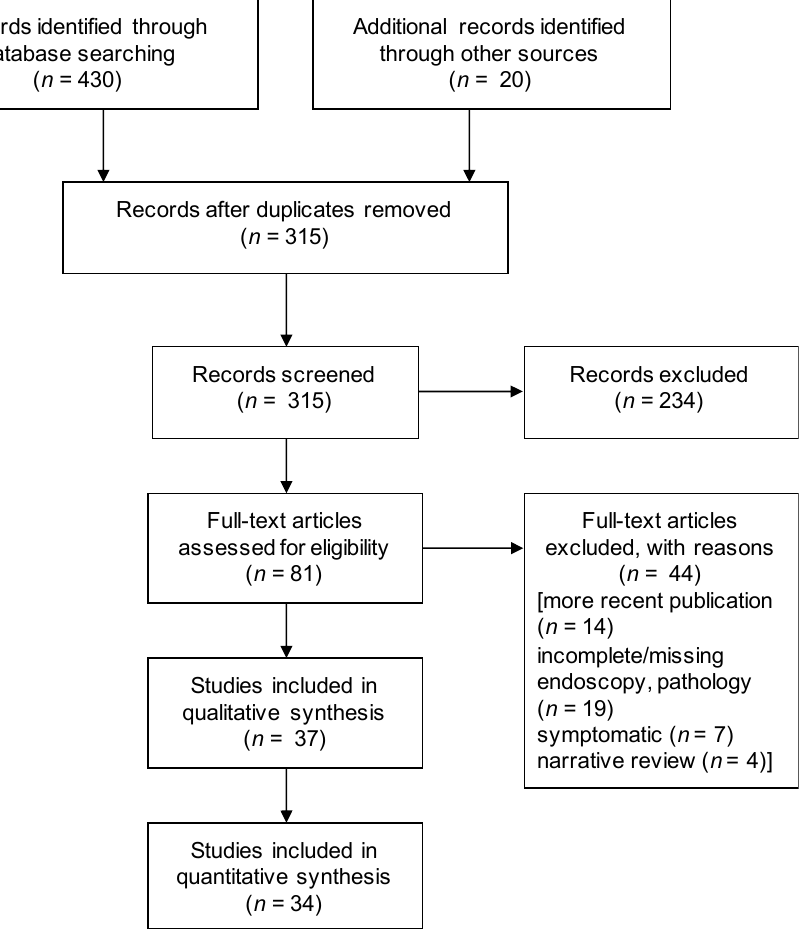
Figure 1. PRISMA study selection flow chart. From our results, we saw no significant difference in the detection rate of cancer foci by endoscopic biopsy, when compared to the final pathology result after PTG (Table 4). The estimated test sensitivity and negative predictive value for random biopsies were 20.9% and 15.2% respectively, while for Cambridge Protocol, these values were 27.1% and 22.1%, respectively. The median number of biopsies taken in the random group was 14.5, though the range varied from 1–60, and data was only present from 43% of all patients, while all Cambridge Protocol patients had a minimum of 30 biopsies per scope. There were no differences in gender distribution, age at surgery, cancer stage at pathology, total foci count, or embedding protocol technique between the two groups.